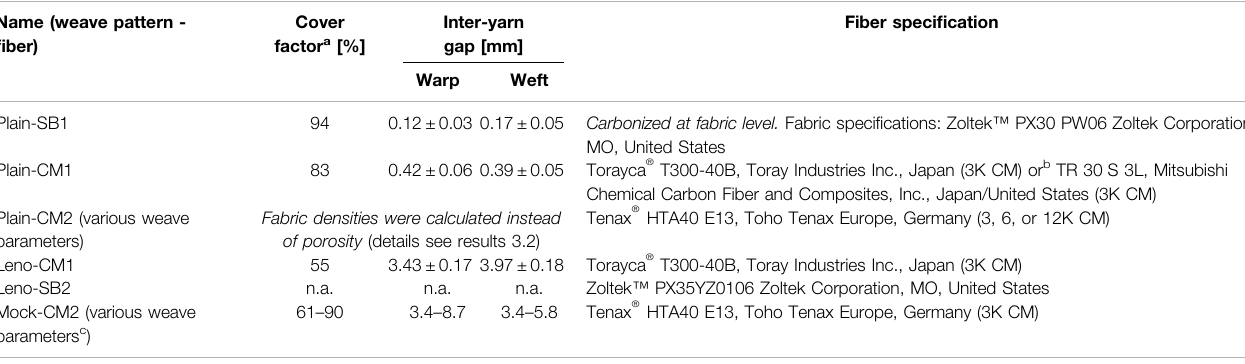
TABLE 1 | CF fabrics used in this